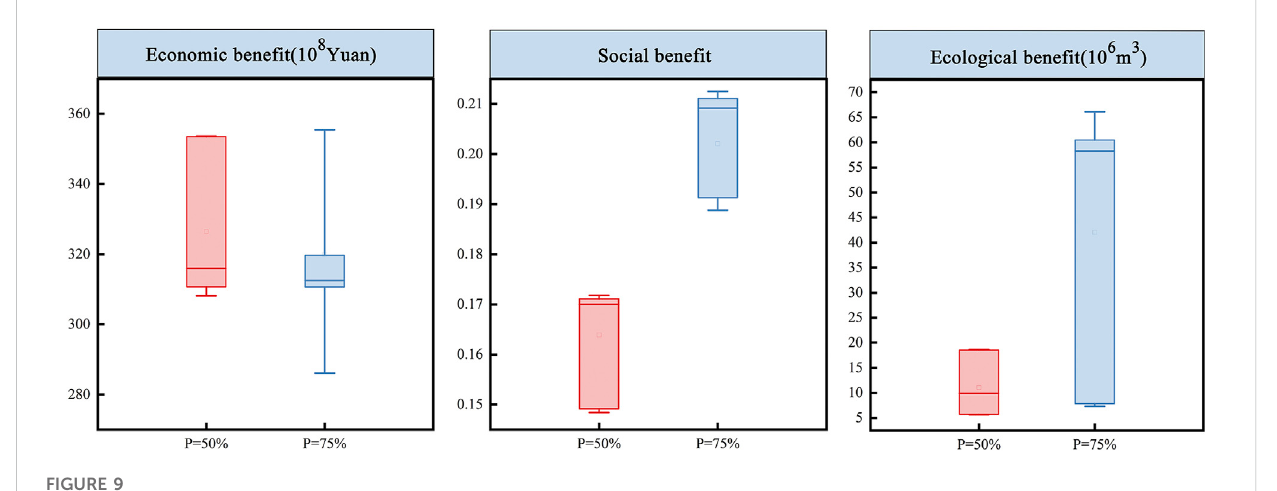
FIGURE 9 Bene fi t values for different level-year option sets in